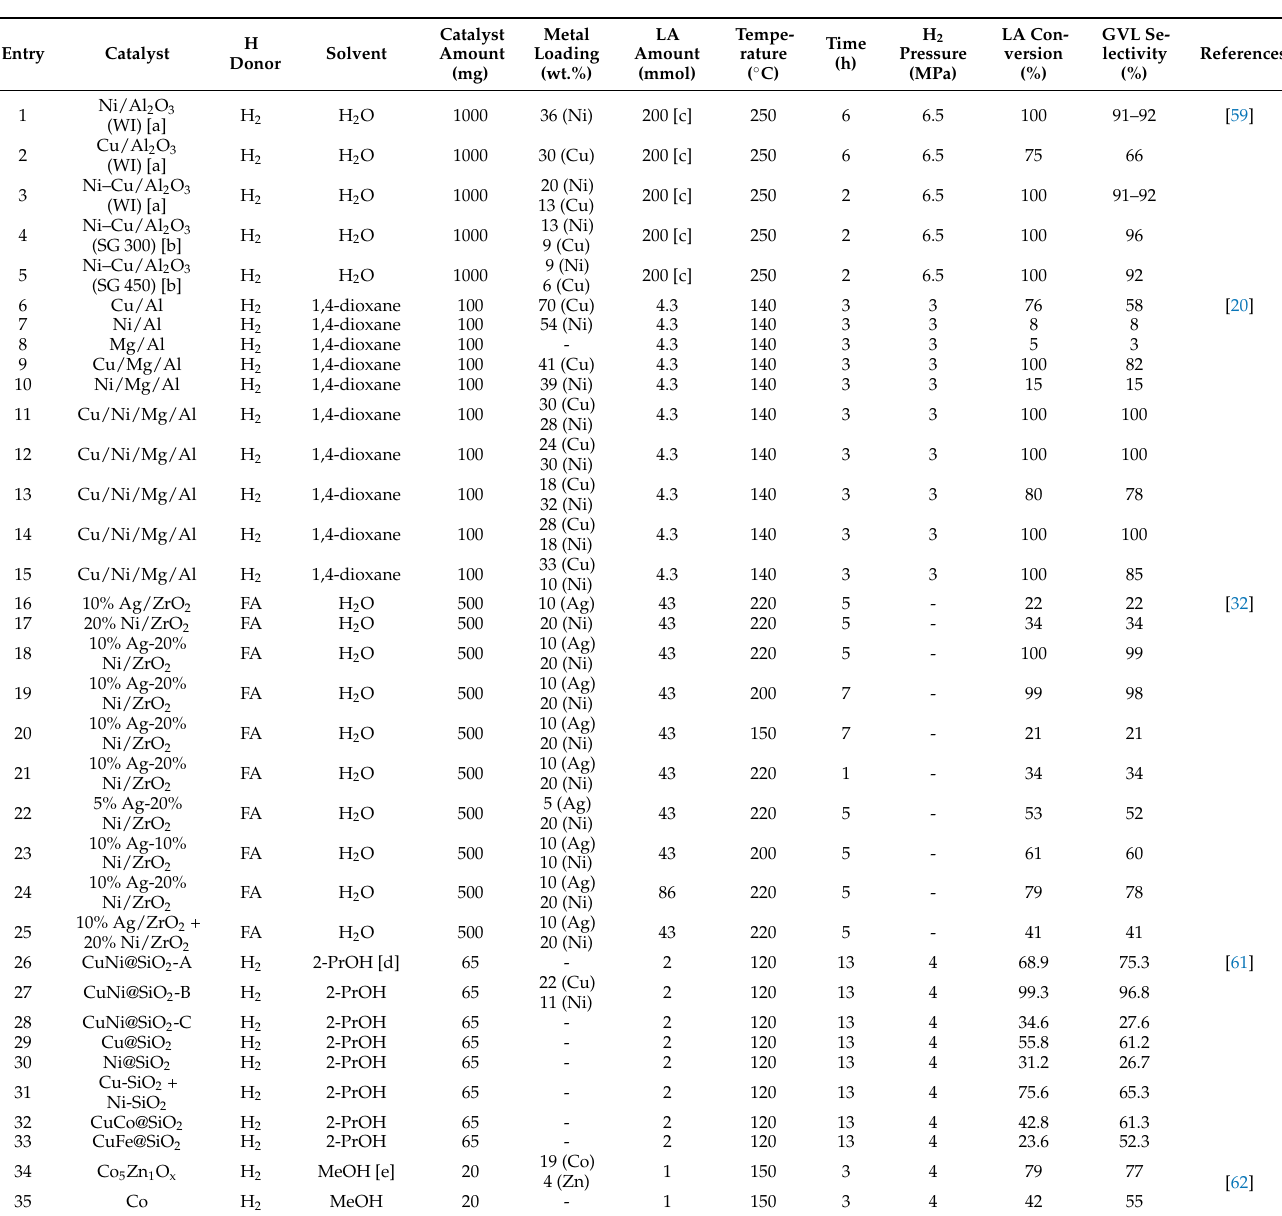
Table 2. Bimetallic catalysts for the hydrogenation of LA to